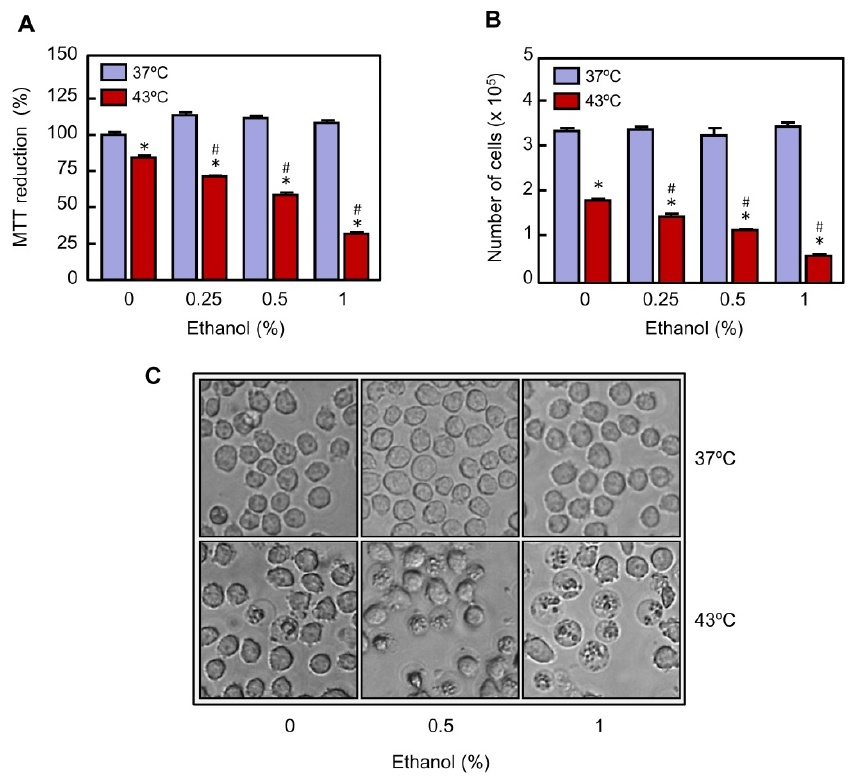
Figure 1. Effect of ethanol on cell viability in U937 cells exposed to hyperthermia. The cells were pre-incubated in absence or presence of the indicated concentrations of ethanol for 30 min, exposed to hyperthermia (30 min at 43 °C) and allowed to recover for 24 h. ( A ) Mitochondrial activity was evaluated by the MTT reduction assay. ( B ) The number of viable cells was determined by the trypan blue exclusion method using an automatic cell counter. ( C ) The cells were visualized under phase contrast microscopy; a representative field of each experimental group is shown. Magnification 20×. * p < 0.05 vs. respective control at 37 °C; # p < 0.05 vs. hyperthermia (43 °C) treatment alone.